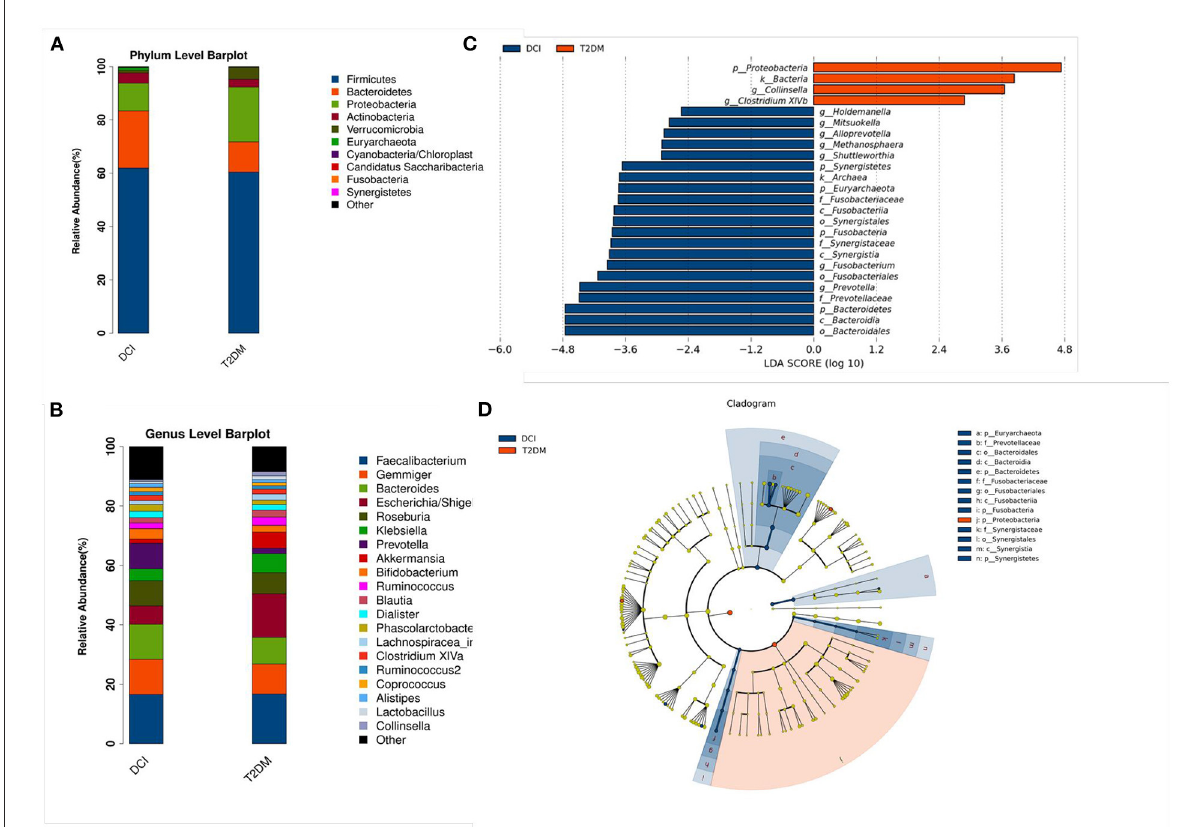
FIGURE2 Changes of gut microbiota between DCI and T2DM groups at the phylum and genus level. (A,B) The bar chart of gut microbiota composition at the level of phylum (A) and genus (B) between the two groups. (C,D) Linear discriminant analysis (LDA) effect size (Lefse) plot and cladogram revealed the unique bacterial signatures identified in DCI and T2DM patients. The LDA scores (log10) > 2 and P < 0.05 are listed.